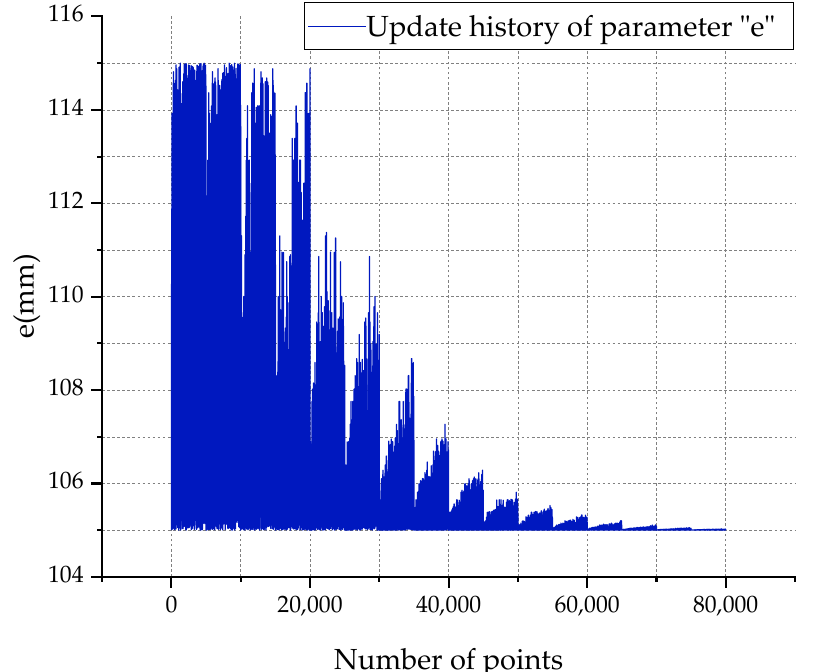
Figure 24. The iterative process of parameter